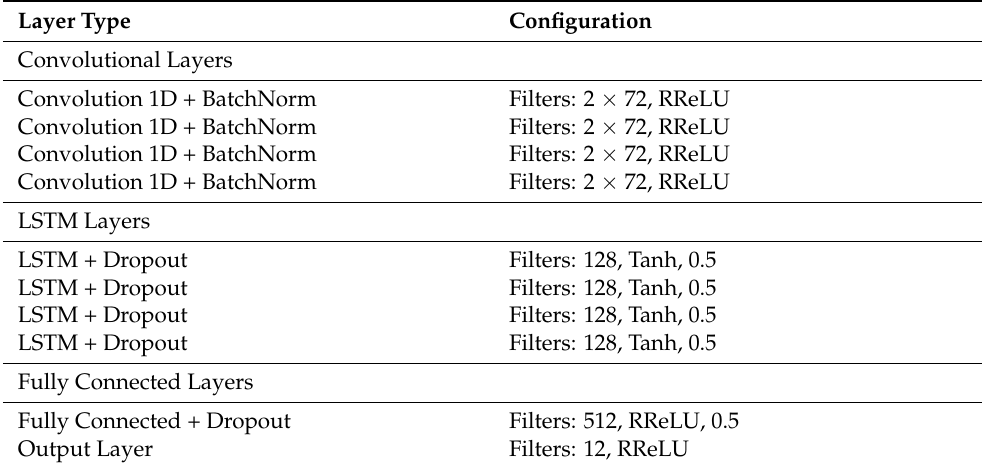
Table 2. The architecture of